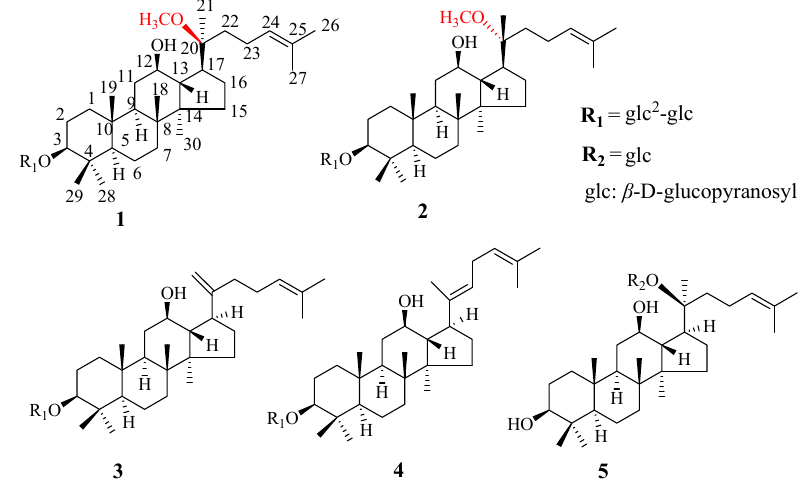
Figure 2. Chemical structures of ginsenosides 1 – 5 .